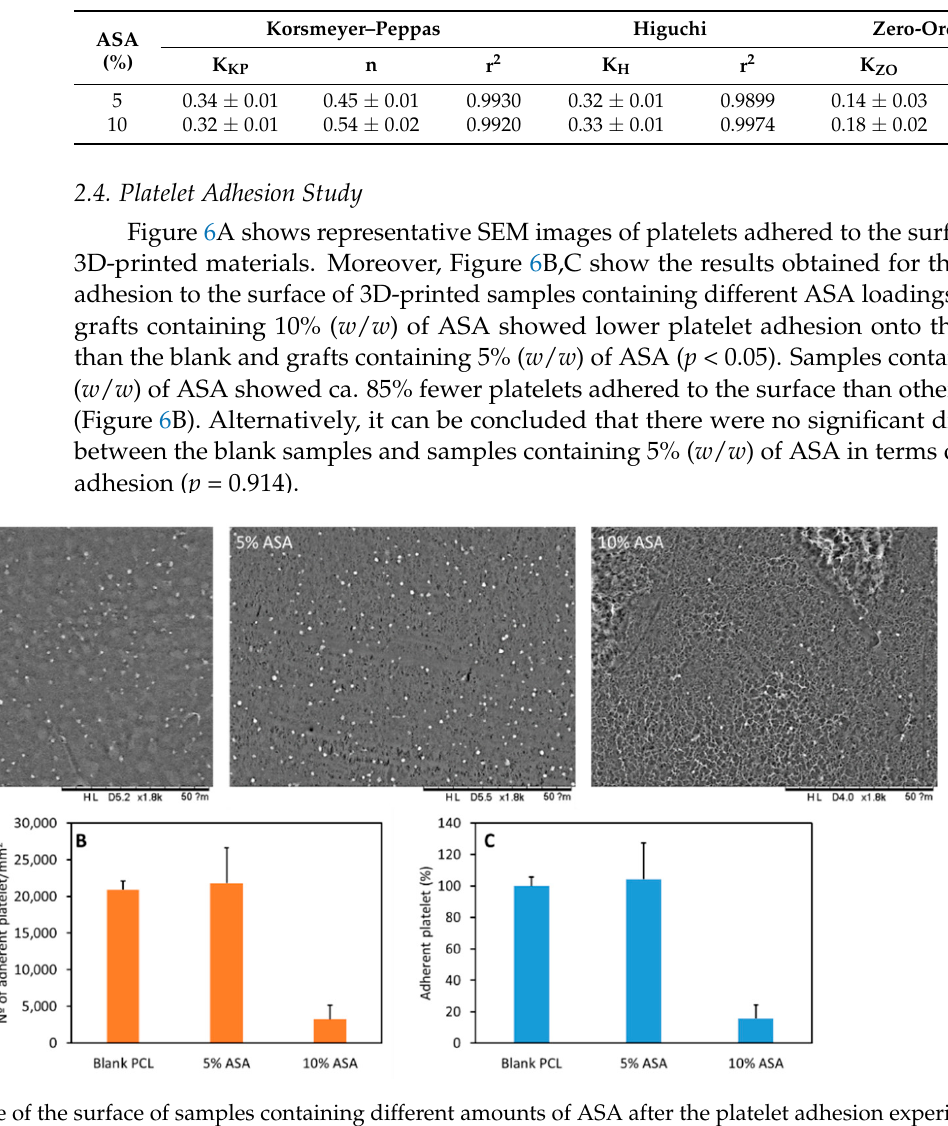
Figure 6. SEM image of the surface of samples containing different amounts of ASA after the ( A ). Platelet adhesion experiment results for samples containing different ASA loadings. Results are expressed in platelet platelet adhesion experiment ( A ). Platelet adhesion experiment results for samples containing per mm 2 ( B ) and percentage of platelets adhered ( C ) using the blank PCL as different ASA loadings. Results are expressed in platelet per mm 2 ( B ) and percentage of plate- lets adhered ( C ) using the blank PCL as reference.